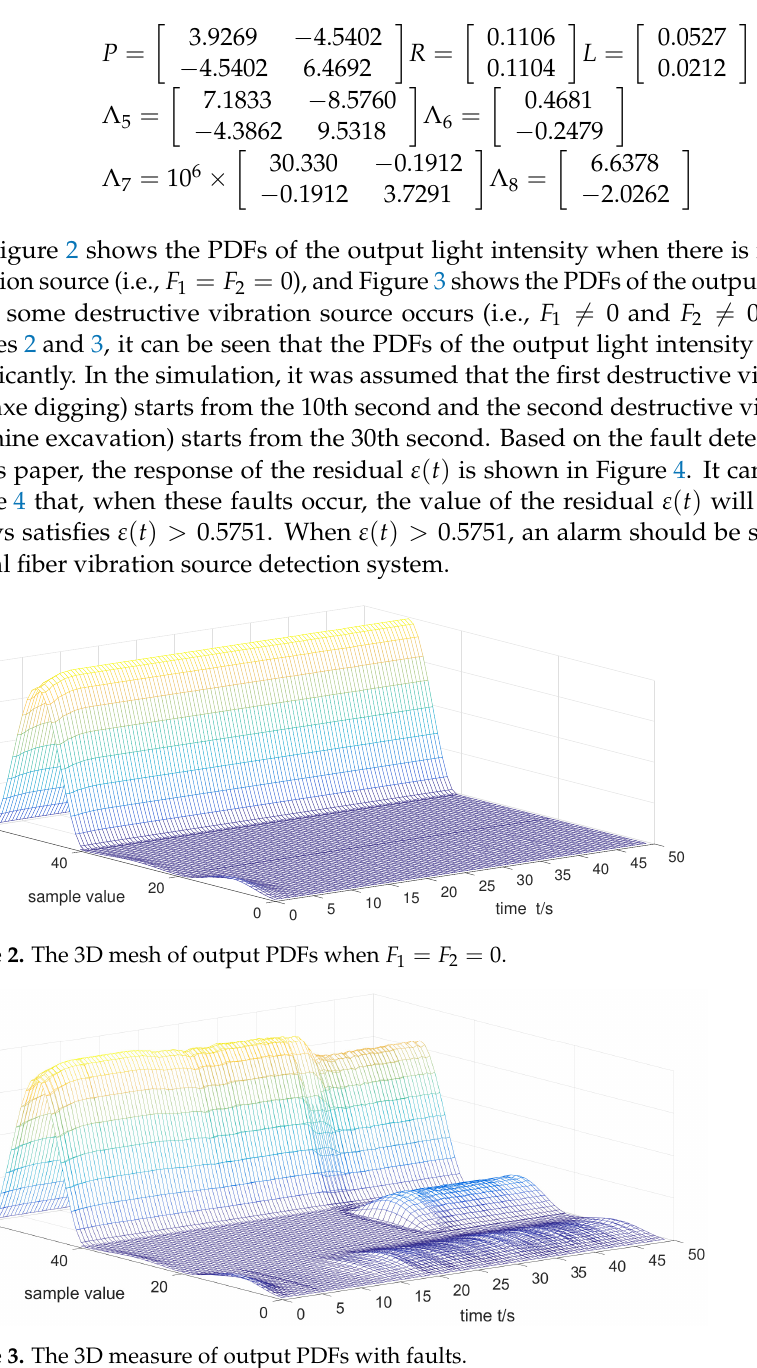
Figure 3. The 3D measure of output PDFs with